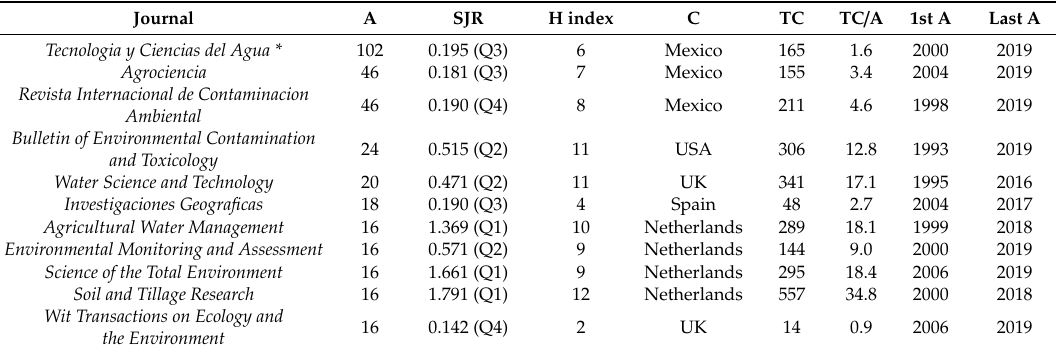
Table 3. Major characteristics of the most active journals related to agricultural water management in Mexico (AWMM)